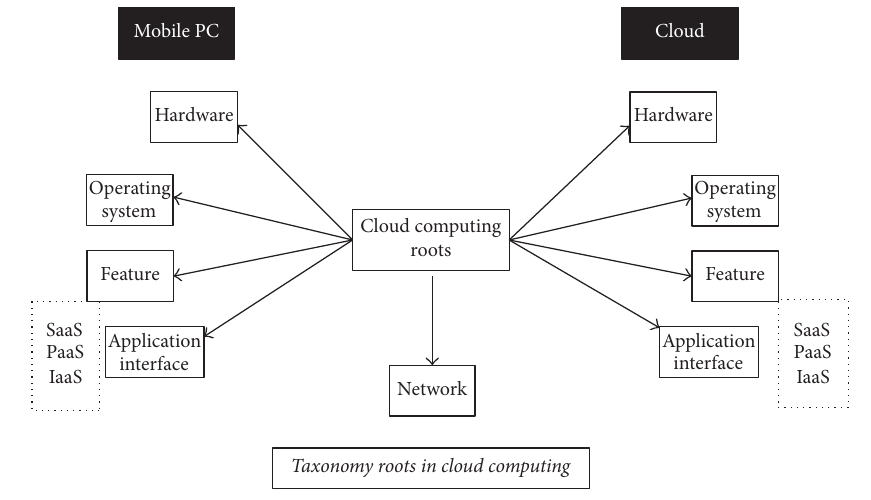
Figure 2: Taxonomy